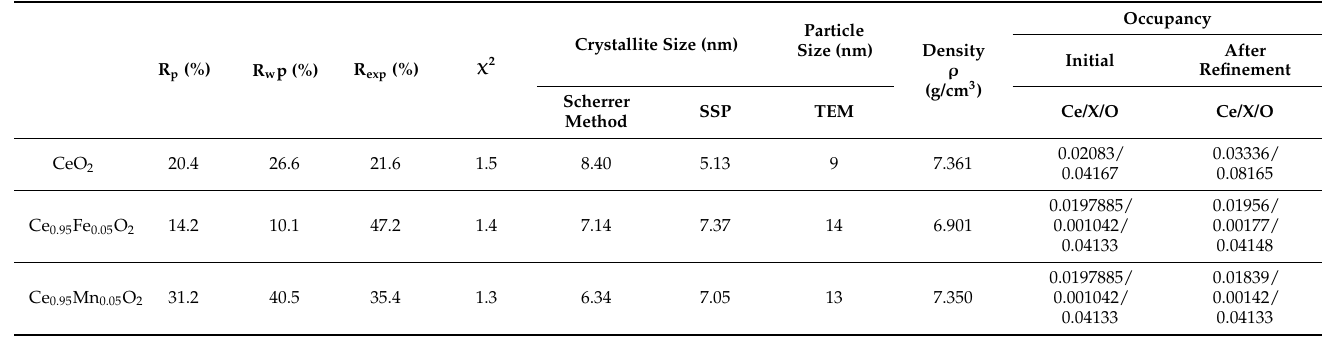
Table 1. The reliability factors, densities, and occupancies were obtained through Rietveld Refinement of undoped and CeXO 2 (X: Fe, Mn) nanoparticles. The crystallite sizes and particle sizes were calculated using various methods.